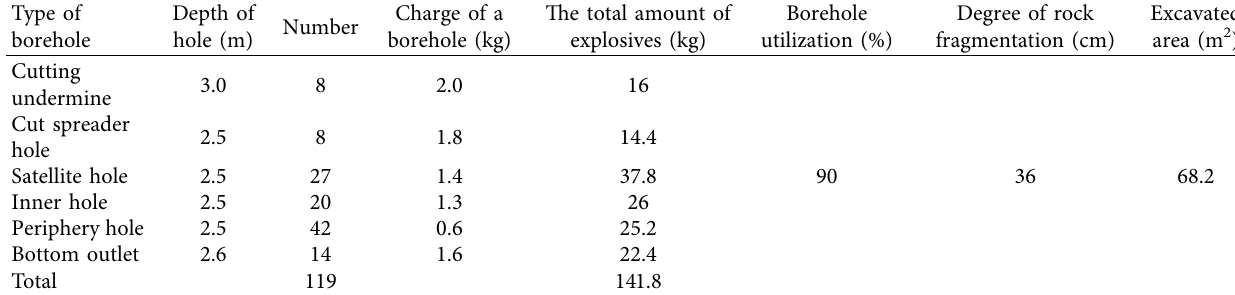
Table 5: Design parameters of ordinary blasting.